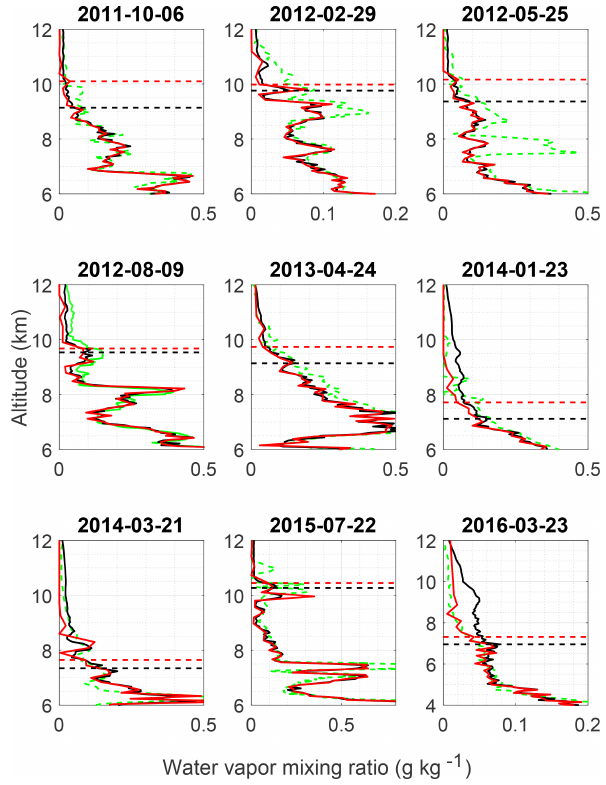
Figure 13. All nighttime water vapor retrievals. The radiosonde is shown by the green dashes, the fine-grid retrieval in black, and the coarse-grid retrieval in red. The 0.9 cutoff height for the fine grid is shown by the black dashed line, while the coarse-grid cutoff height is the horizontal red dashed line.